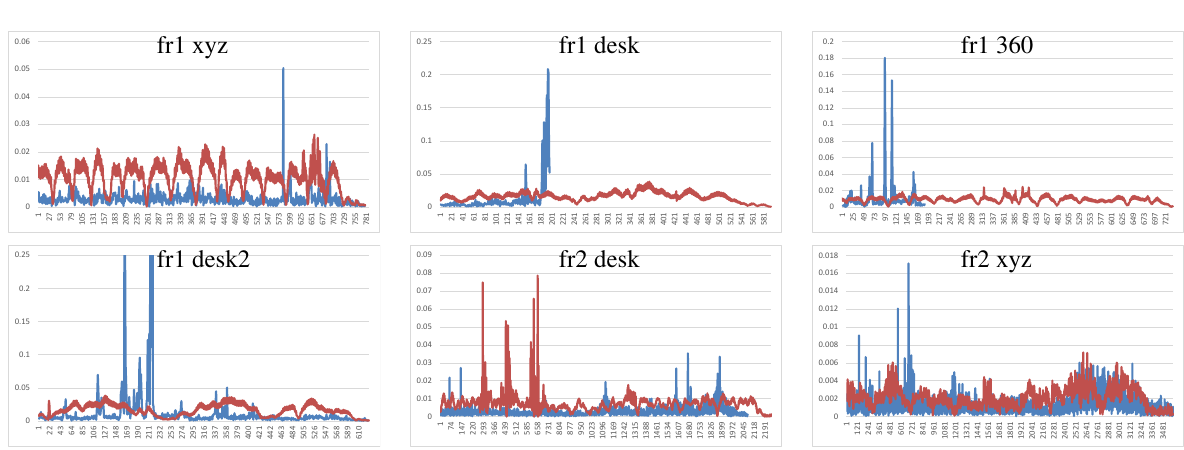
Figure 7. Blue: KinectFusion relative pose translational errors (y-axis, meters) on the selected datasets (x-axis, frames). Red: relative ground-truth motion (meters).